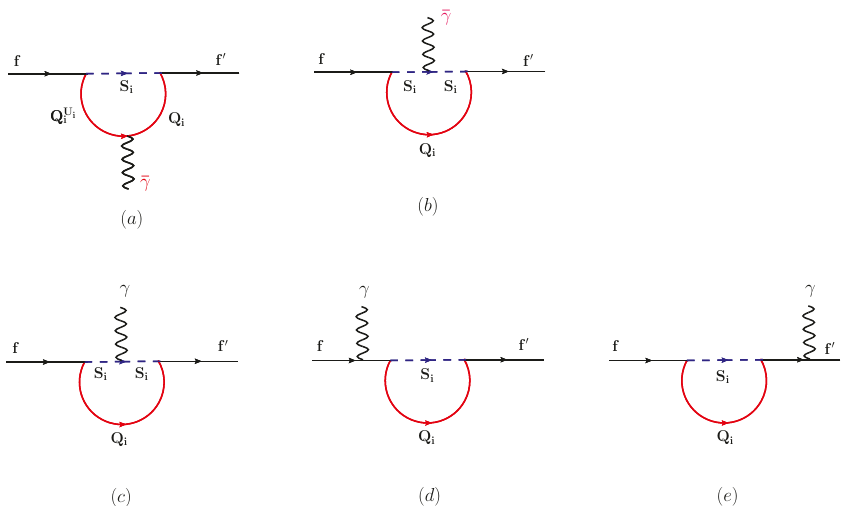
Figure 10 . Feynman diagrams for the contributions to the dark-photon (cid:22) (cid:13) (a-b) and photon (cid:13) (c-e) magnetic-dipole interactions [83]. Dark continuous lines correspond to external SM fermions f; f 0 , (red continuous lines) and (blue dashed lines) refer to generic dark-fermion ( Q i ) and scalar messenger ( S i ) propagators